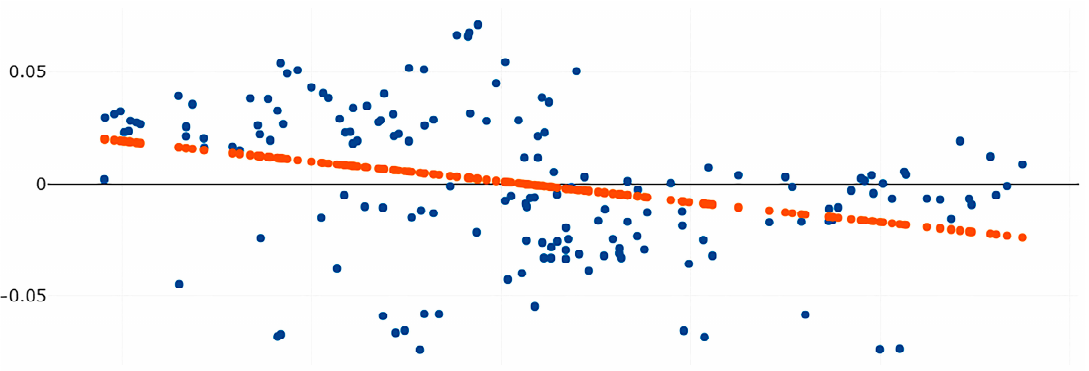
Figure 3. Scatter diagram showing the relationship between wing size (the x -axis) and wing shape (the y -axis) using landmark-based GM analysis. The linear regression prediction result is represented by the orange dots. While blue dots indicate individual mosquitoes.